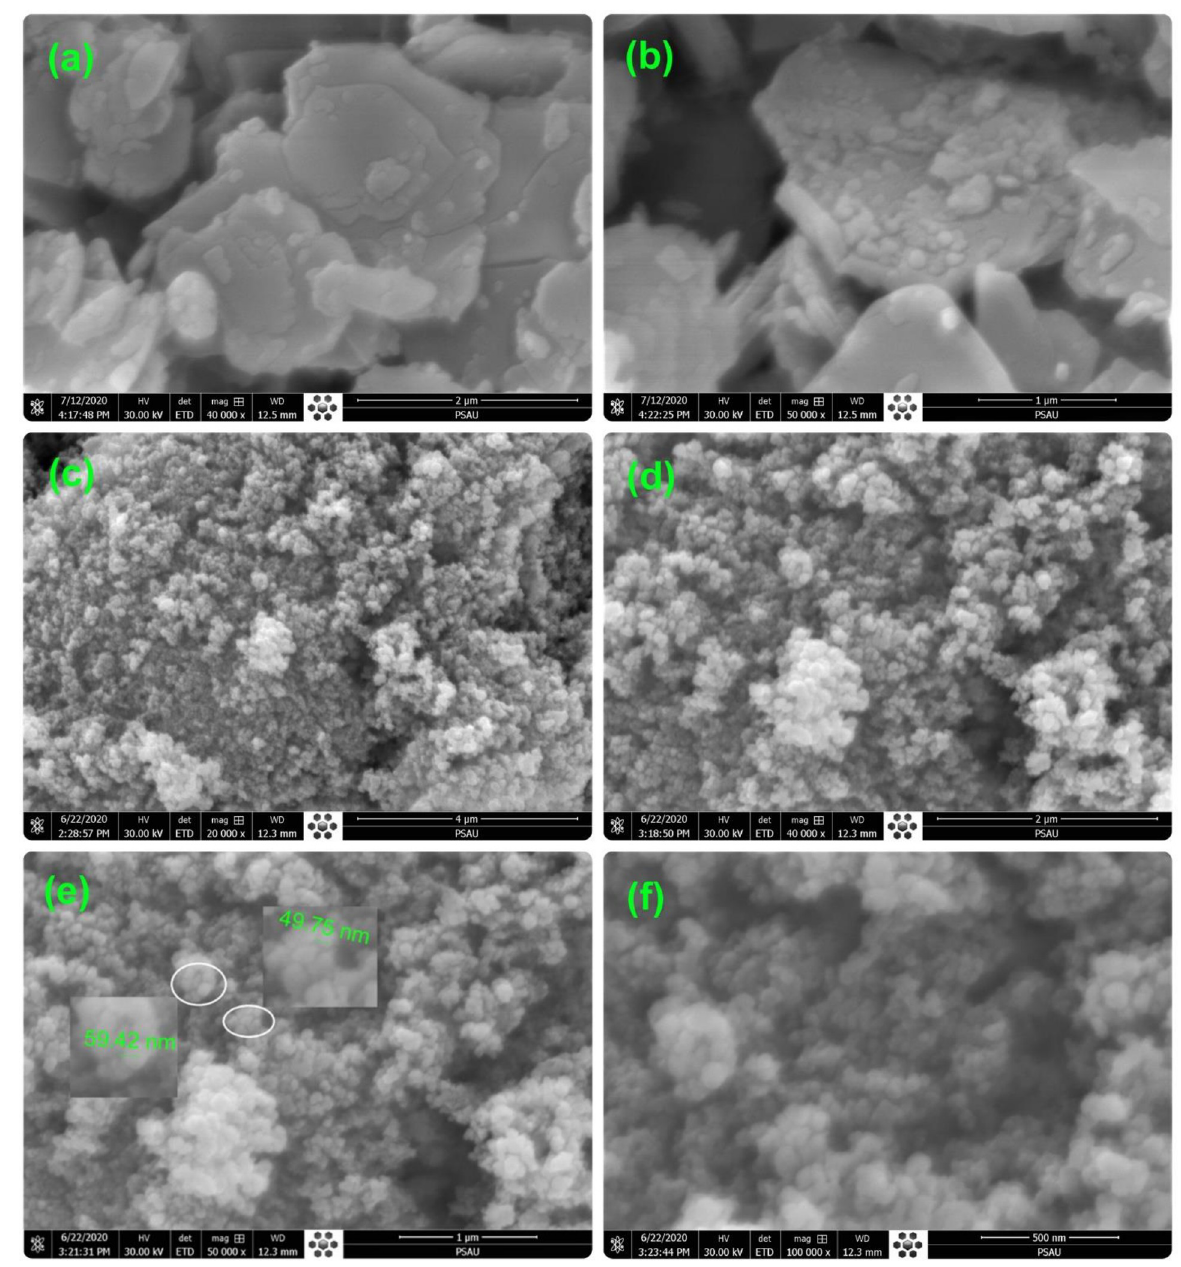
Fig 1. FESEM micrograph of pure and Cu-doped ZnO-NPs: pure ZnO (a) 2 μ m and (b) 1 μ m, Cu doped ZnO (c) 4 μ m (d) 2 μ m (e) 1 μ m (f) 500 nm. https://doi.org/10.1371/journal.pone.0251082.g001 attributed to E –E , A transverse optical (TO), and E (high) mode respectively [39]. The 2H 2L 1 2 results according to the literature showed that when the Cu doping concentration is increased, the intensities of the peaks in the spectrum decrease, and the A (TO) phonon mode vanishes 1 [40]. According to group theory, the other reported peaks in the Raman spectrum corresponds to different optical modes. Here, A and E modes, are polarized and can be divided into trans- 1 1 verse optical (TO) and longitudinal optical (LO) phonons [41].